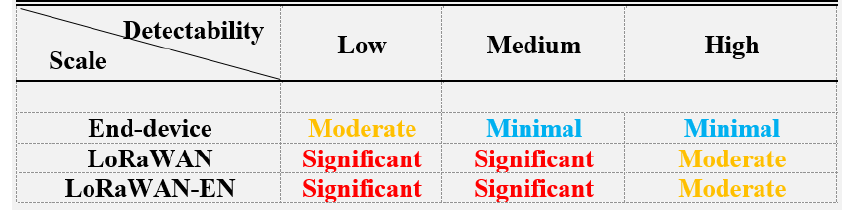
Figure 4. Impact of an attack.